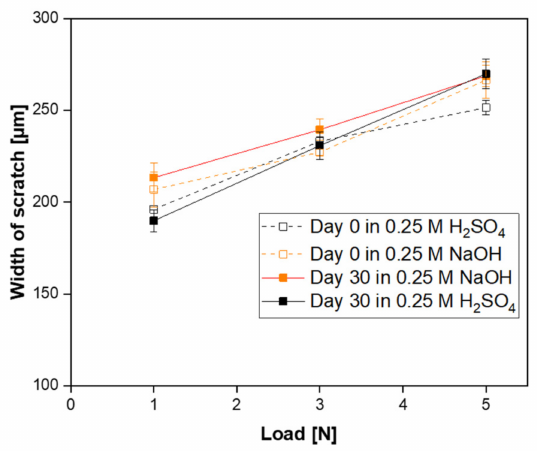
Figure 10. Width of scratch as a function of the applied loads for prepared SiC membranes before and after corrosion resistance test in alkali and acidic